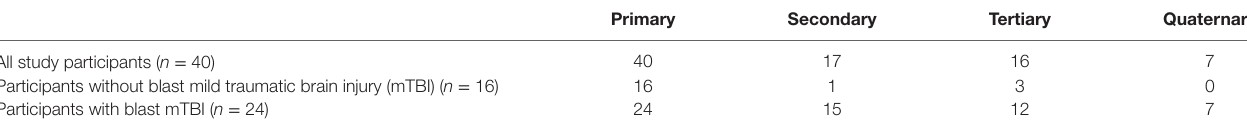
TaBle 2 | Type of blast